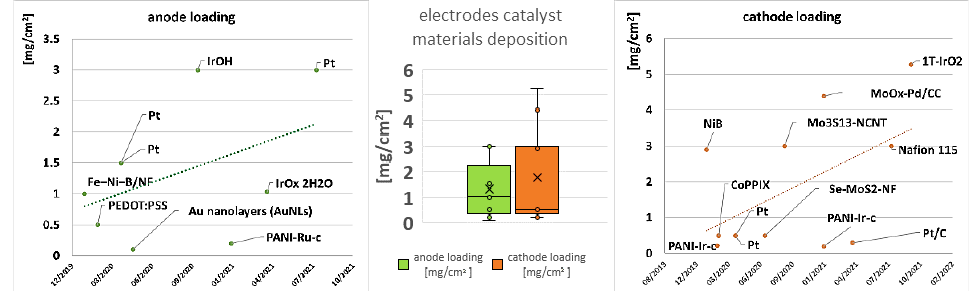
Figure 9. This is a representation of the anode and cathode specific mass catalyst deposition.